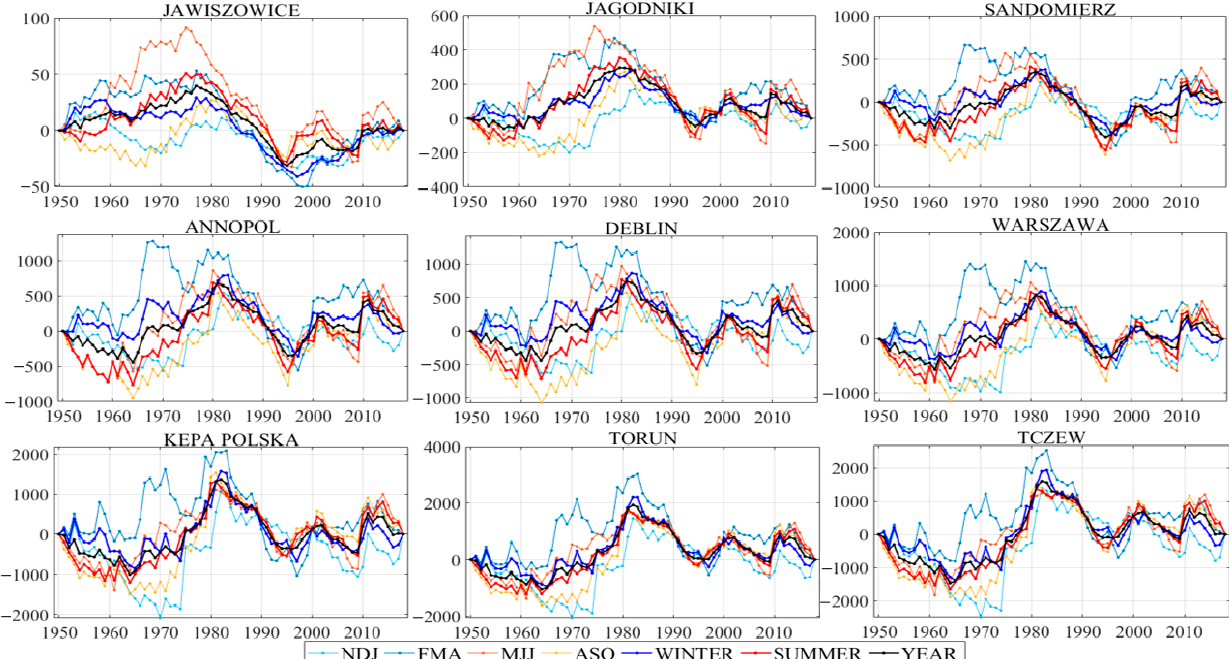
Figure 3. Mass curves of mean annual flow (MQ) in the reduced variable coordinates along the course of the Vistula River (values for different seasons: NDJ—MQ for November–December–January, FMA—MQ for February–March–April, MJJ— MQ for warm half of the year, YEAR—MQ for the year); MQ in m 3 /s.